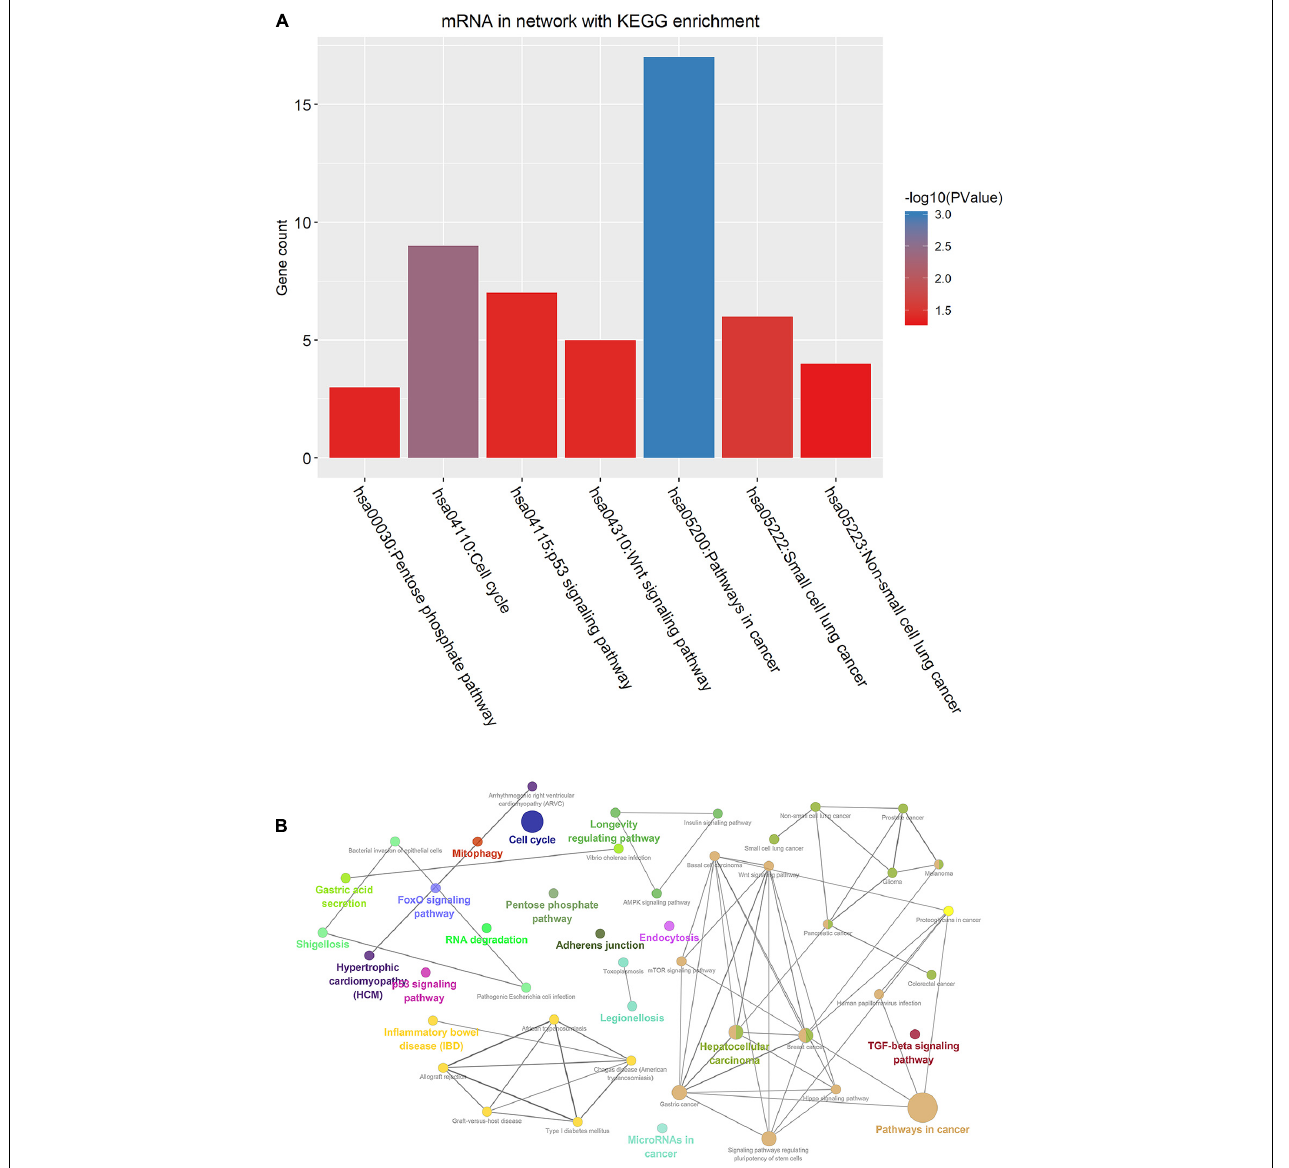
FIGURE 7 | KEGG pathway enrichment analysis of DEmRNAs in the ceRNA network. (A) Seven enriched KEGG pathways. (B) Visualization of KEGG enrichment analysis results. DEmRNAs: Differentially expressed mRNAs.